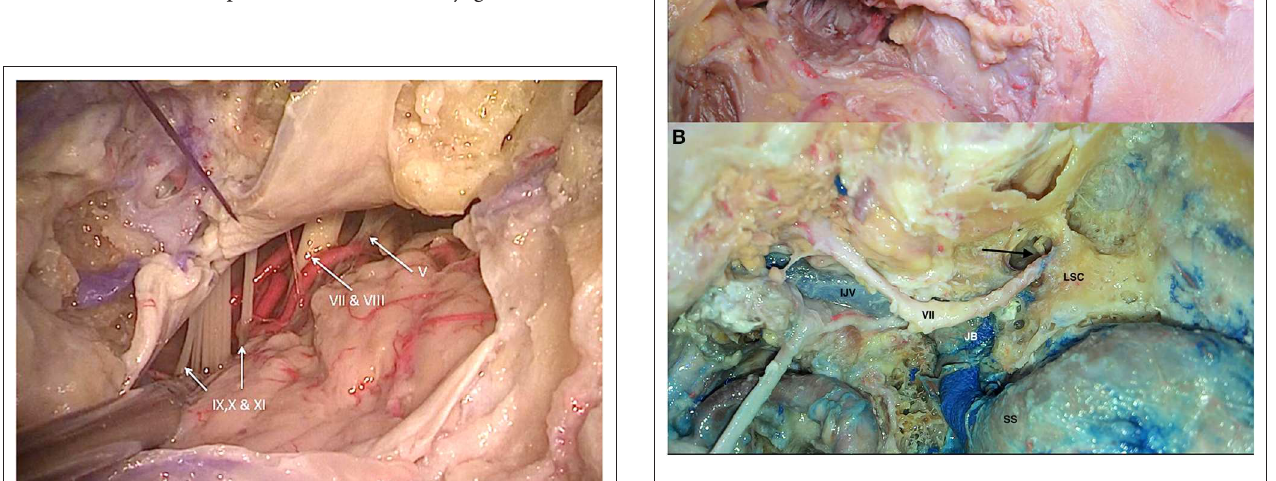
FIGURE 8 | Landmarks to identify the facial nerve [Modified from Ramina and Tatagiba (3)]. (A) Extracranial facial nerve location in relation to the tragal pointer, mastoid tip (MT) and digastric muscle (DM). (B) Facial nerve after mastoidectomy, with the incus pointing toward the transition between the tympanic and mastoid segment of the facial nerve (arrow). IJV, internal jugular vein; JB, jugular bulb; LSC, lateral semicircular canal; SS, sigmoid sinus; VII, facial nerve.